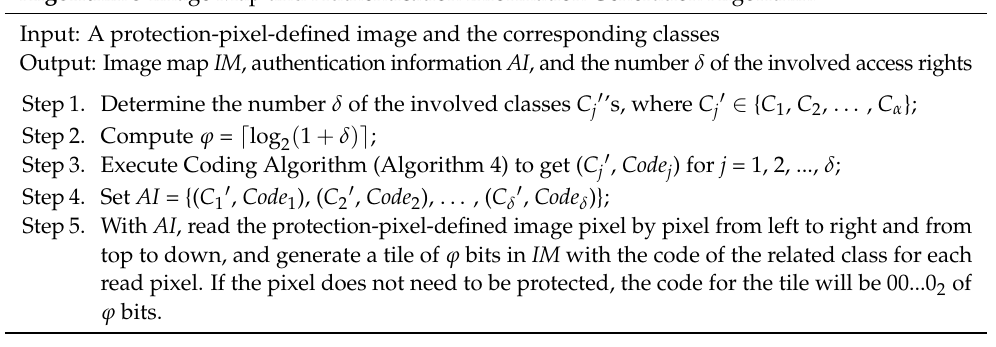
Algorithm 3 Image Map and Authentication Information Generation Algorithm.